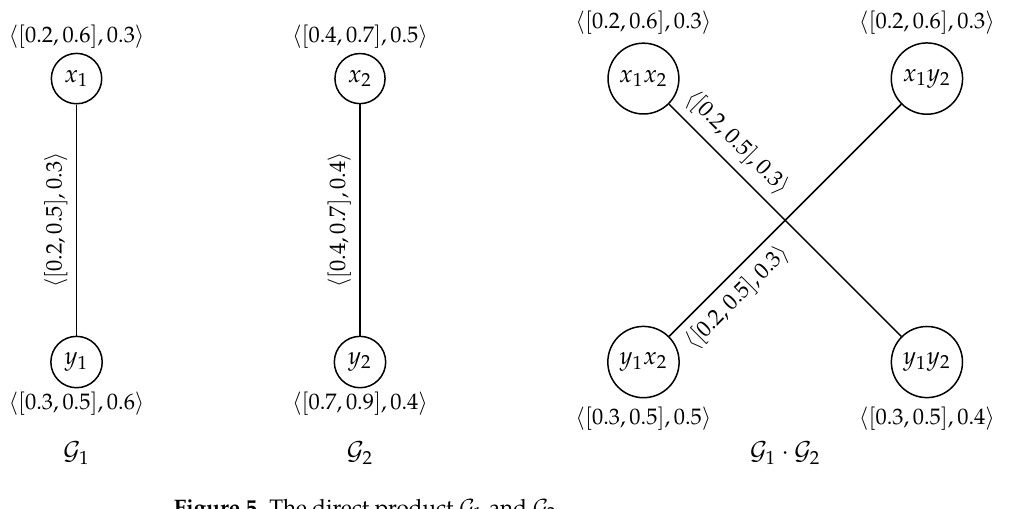
Figure 5. The direct product G 1 and G 2